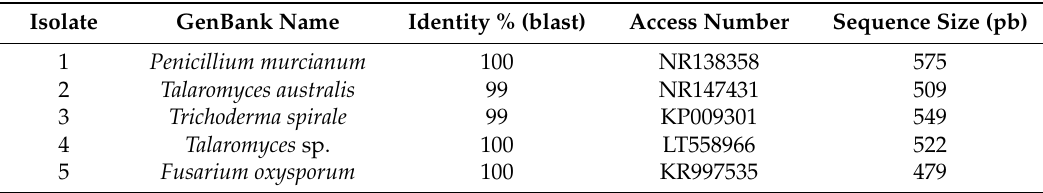
Table 1. Identification of fungi isolated from rotten wood samples.